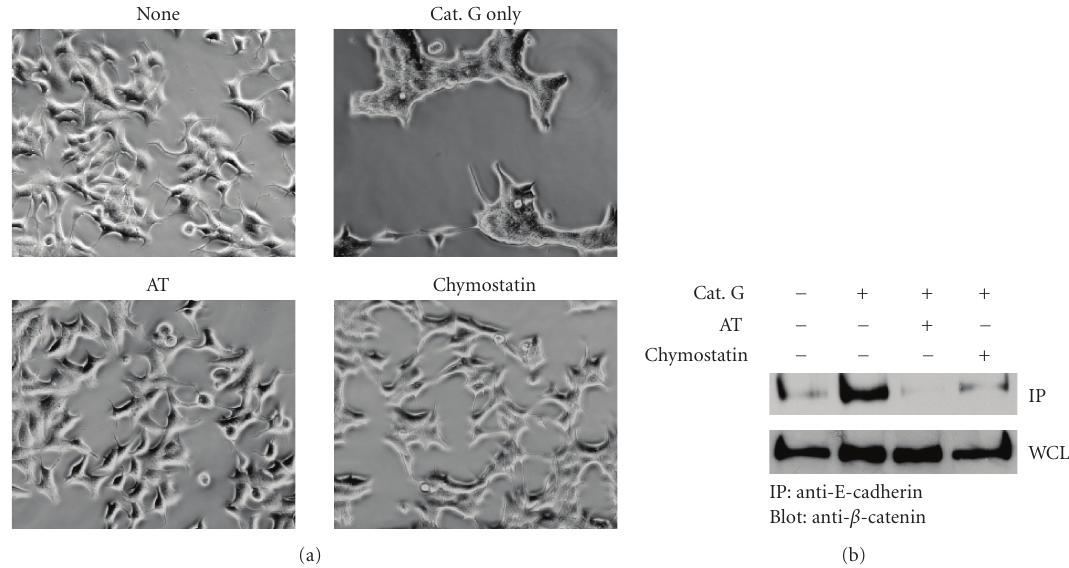
Figure 5: Enzymatic activity of cathepsin G is required for cathepsin G-promoted E-cadherin-mediated cell-cell adhesion. MCF-7 cells were incubated in 5% FBS-containing medium on fibronectin for 24 hours. (a) After washing, the adherent cells were treated with cathepsin G in the absence or presence of 50 μ g/mL chymostatin or 200 μ g/mL α 1 -antitrypsin (AT) for 24 hours. Cathepsin G-induced cell condensation was observed by phase-contrast microscopy. (b) After washing, adherent cells were treated with cathepsin G in the absence or presence of 50 μ g/mL chymostatin or 200 μ g/mL α 1 -antitrypsin (AT) for 3 hours. The immunocomplexes with anti-E-cadherin were then analyzed by immunoblotting with anti-E-cadherin using an anti- β -catenin